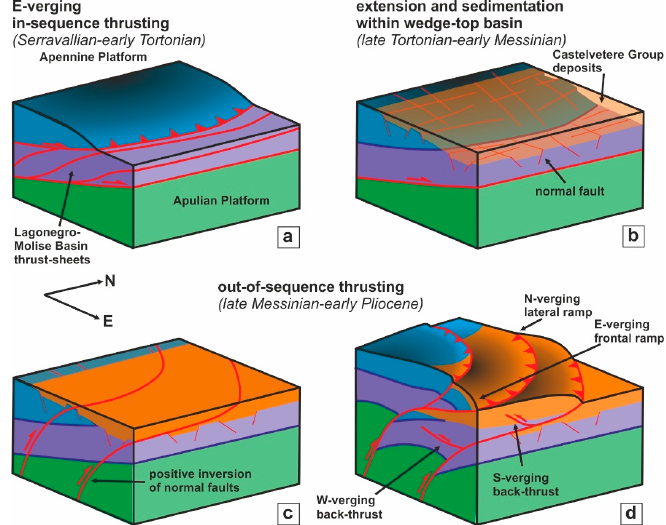
Figure 12. ( a – d ) Cartoon showing the tectono-stratigraphic evolution scheme of the analyzed area between the Serravallian and early